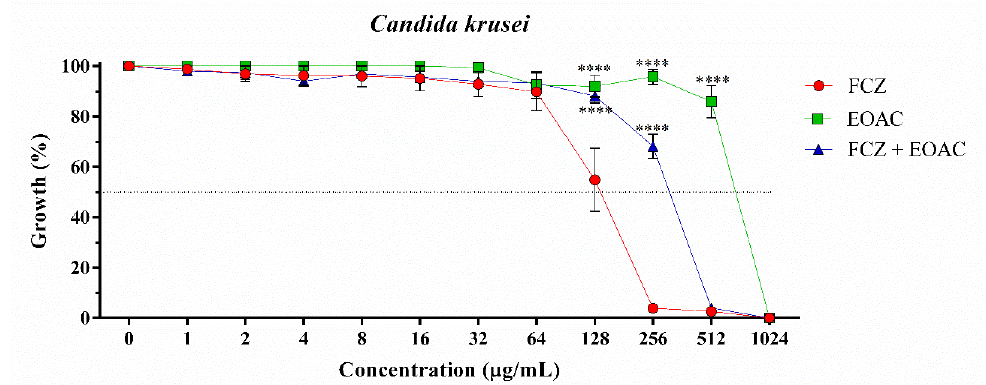
Figure 1. Cell viability curve of Candida albicans INCQS 90028 against essential oil of Acritopappus confertus (EOAC) and f luconazole (FCZ) in μg/mL. Statistically significant value with * p < 0.05.